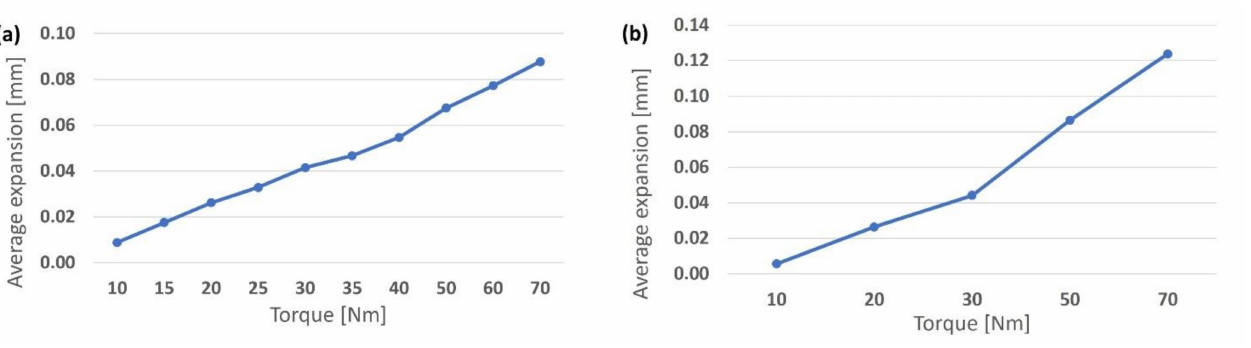
Figure 12. Test 1a—Average ring deformations of bearing rings on ( a ) non-lubricated and ( b ) lubri- cated single sleeve.